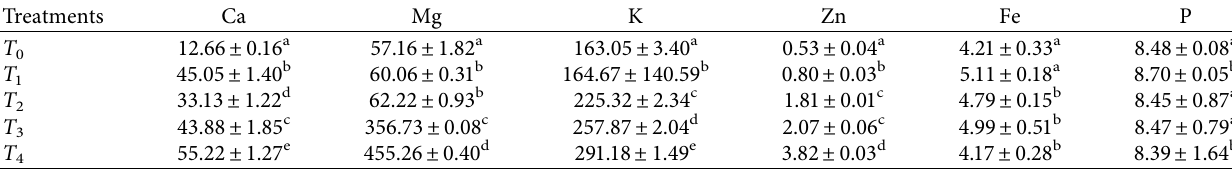
Table 4: Mineral composition of moringa leaf powder (MLP)-supplemented whole wheat four leavened bread (mg/100 g). Treatments Ca